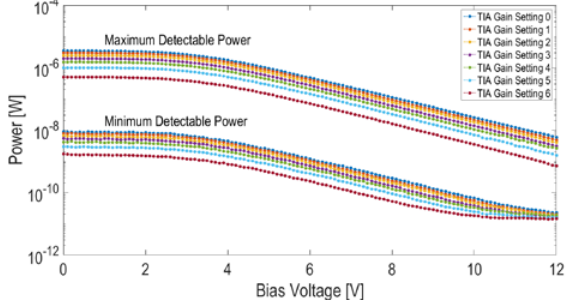
Figure 2. MCT e-APD 2- µ m detection system dynamic range versus bias voltage using different gains. Results are obtained for the 2×2 center pixels at